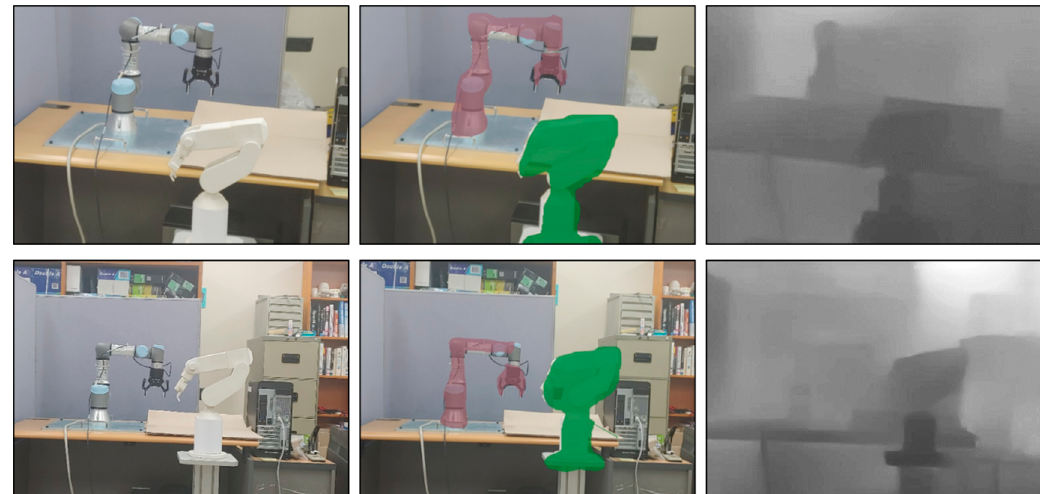
Figure 19. Limitation in depth prediction.